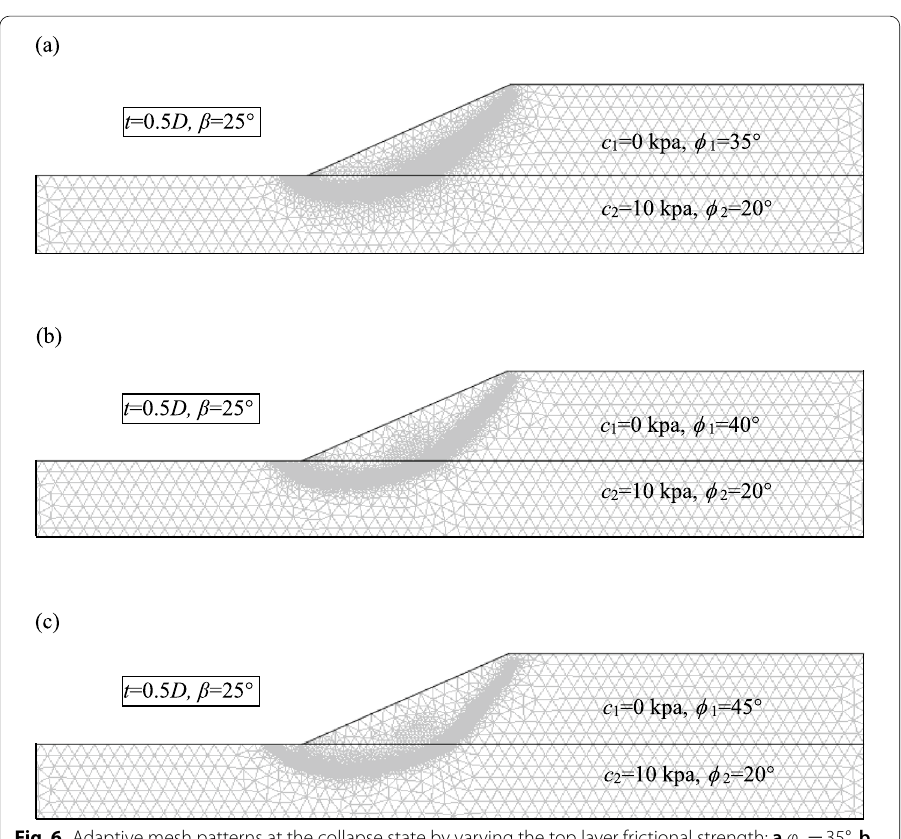
Fig. 6 Adaptive mesh patterns at the collapse state by varying the top layer frictional strength: a φ 1 φ